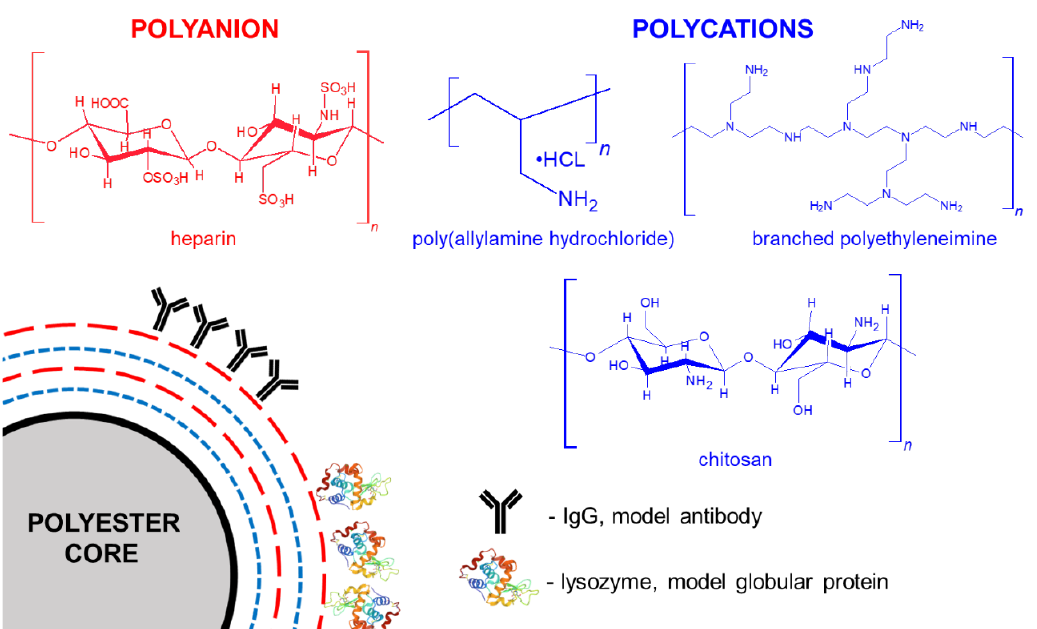
Figure 2. Schematic representation of fabricated core-shell microparticles with molecular structure of macromolecules employed in Lbl assembly.